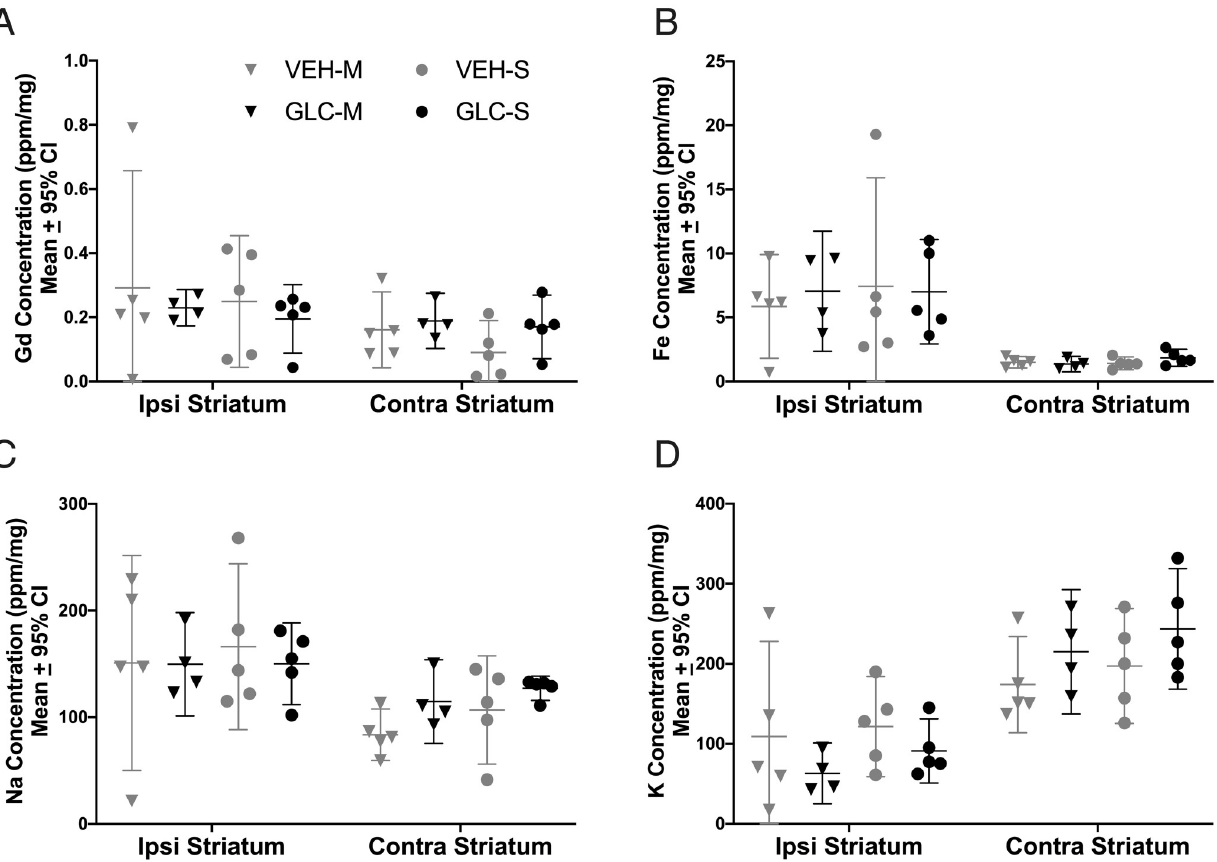
Fig 5. Experiment 2 ICPMS and BBB integrity. Gd (A), Fe (B), Na (C) and K (D) concentrations were analyzed using ICPMS. After ICH, Gd was not significantly different between hemispheres (A, p = 0.0611). Fe (B, p < 0.0001) and Na (C, p = 0.0033) were significantly increased in the ipsilateral hemisphere, and K (D, p < 0.0001) was significantly decreased in the ipsilateral hemisphere. Glibenclamide did not affect Gd (p = 0.8061), a measure of BBB integrity, Fe (p = 0.9466), an estimator for hematoma volume, Na (p = 0.7027), or K (p =